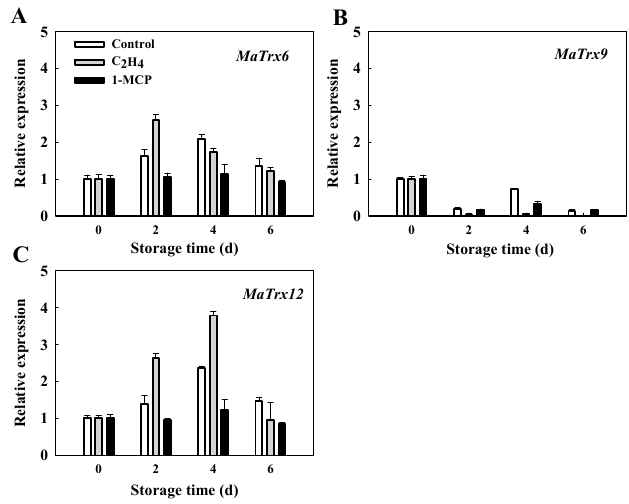
Figure 4. Visual appearance and physiological characterization of banana fruit stored at 6°C. Visual appearance ( A ) of banana fruit treated with ethylene and 1-MCP for 12 h after 6 days of storage at 6 °C. Effect of ethylene and 1-MCP pretreatments on chilling injury ( B ) and color parameter ( C ) of banana fruit stored at 6 °C. The hue angle of 120 means green color while 90 means yellow color.